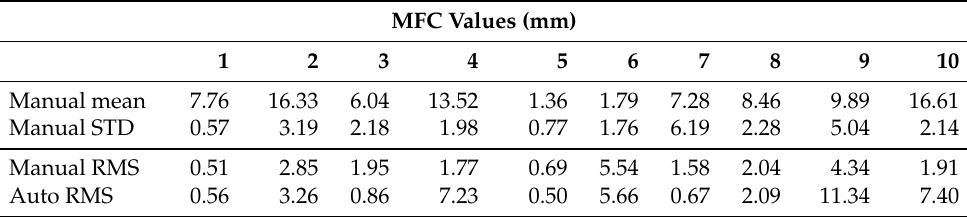
Table 2. The manual measurements’ mean and standard deviation and the manual and automatic measurements’ root mean squared error for Minimum Foot Clearance (MFC) measurement (mm) for each of the